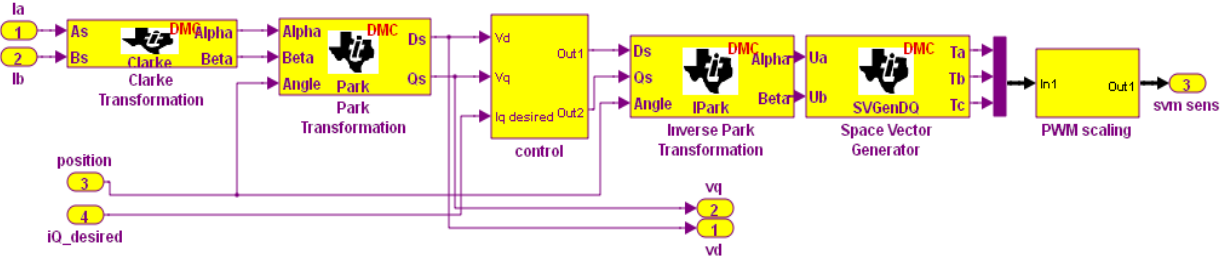
Figure 3. Simulink implementation of sensor vector